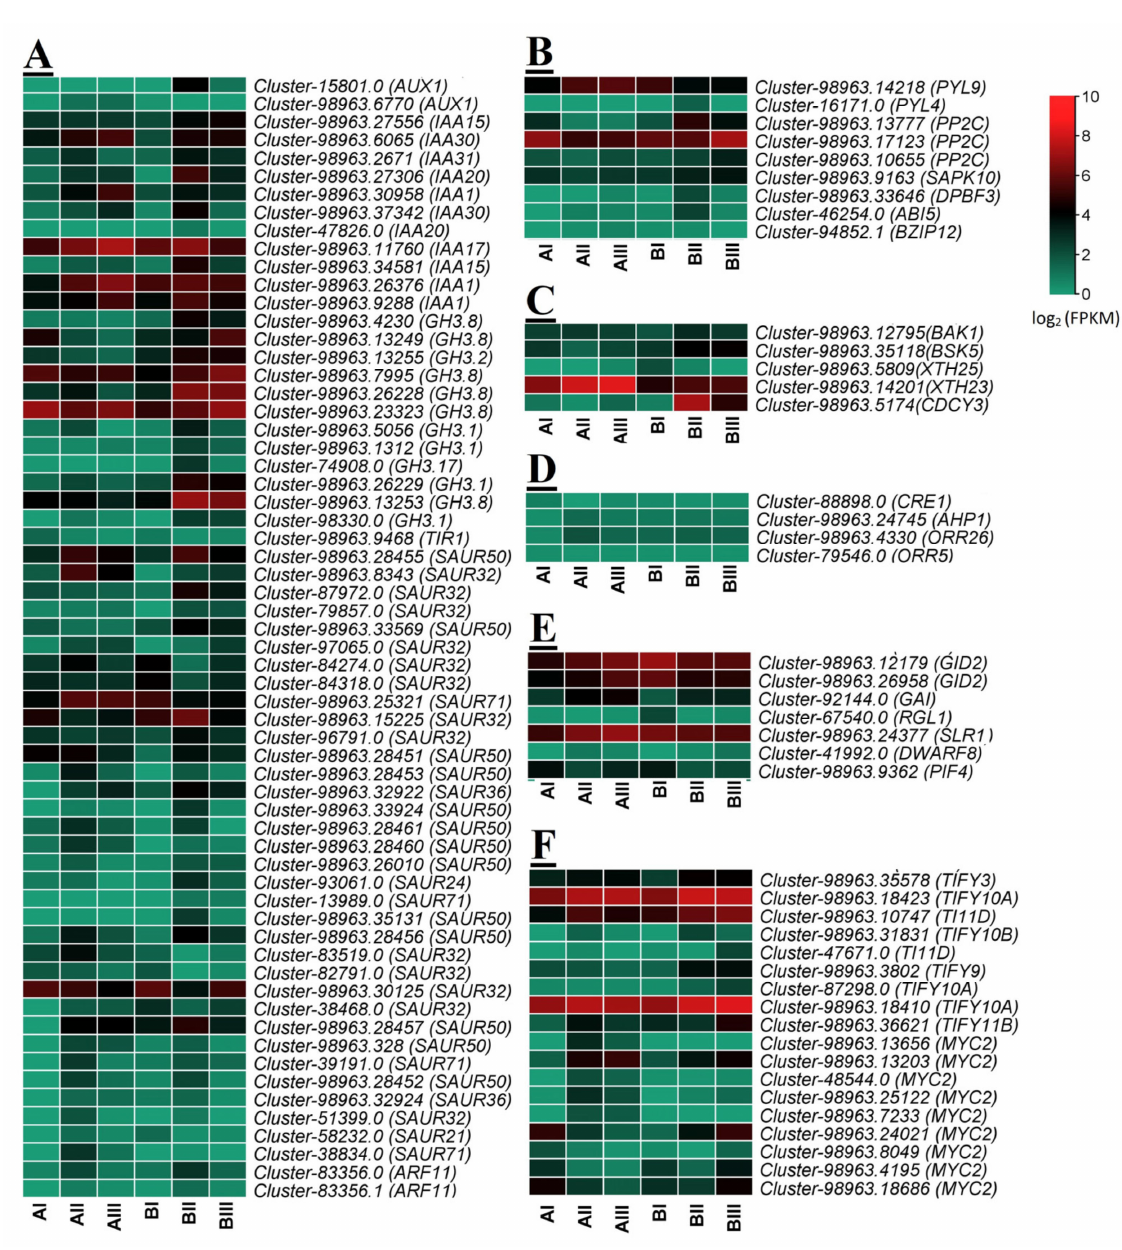
Figure 4. Expression patterns (FPKM) of the expressed genes in the six transcriptomes, assigned to auxin ( A ), abscisic acid ( B ), brassinosteroids ( C ), cytokinin ( D ), gibberellins ( E ), and jasmonic acid ( F ) biosynthesis, respectively. Red and green colors indicate up- and down- regulated transcripts, respectively. AI—vertical (control) group after 20 days of planting; AII—horizontal group after 20 days of planting; AIII—slant group after 20 days of planting; BI—vertical (control) group after 50 days of planting; BII—horizontal group after 50 days of planting; BIII—slant group after 50 days of